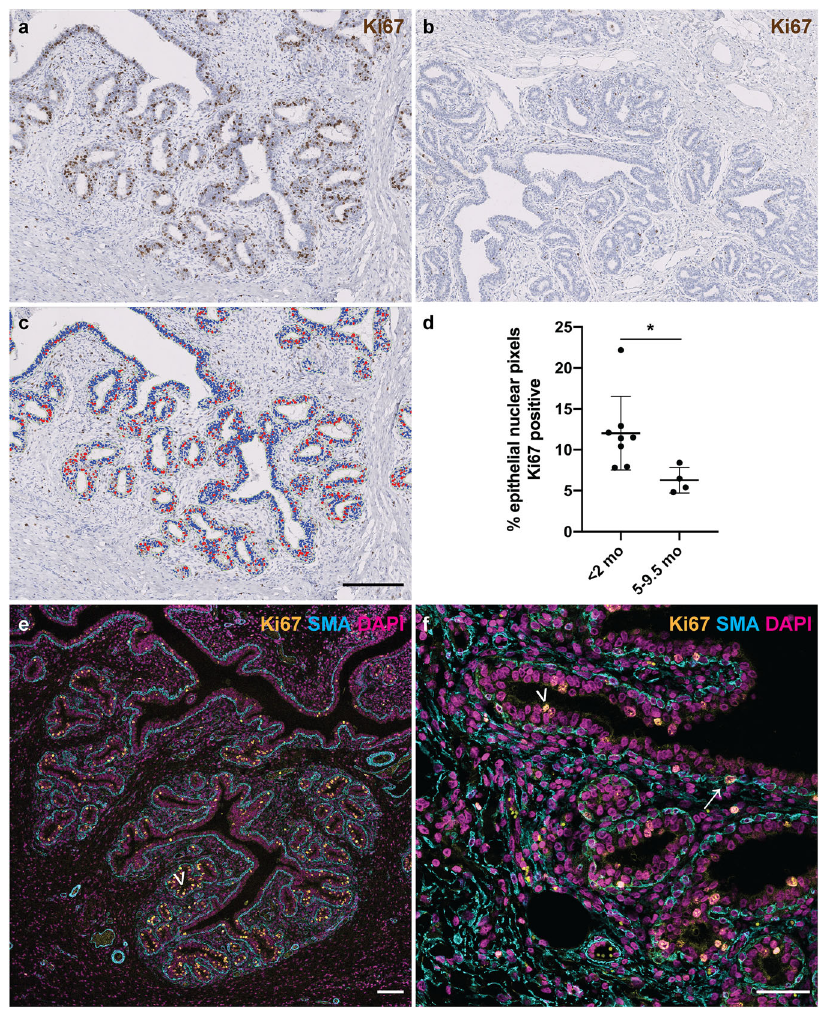
Fig. 2 Mammary epithelial proliferation is signi fi cantly higher in younger lambs than in those approaching puberty. a – c IHC for Ki67 in mammary gland from lambs < 2 mo ( a ) and 5 – 9.5 mo ( b ) and accompanying mask derived using an algorithm detecting intra-epithelial Ki67 positive events ( c ). d Scatter plot demonstrating that the distributions of epithelial nuclear Ki67 positivity differ signi fi cantly between younger and older lambs. Dots represent individual lambs. Bars represent mean ± standard deviation. * p < 0.05. e , f IF for Ki67 (gold), α -SMA (cyan) and DNA (DAPI; magenta) demonstrating that the majority of Ki67 positive nuclei are in the luminal epithelial layer (arrowheads), with rare Ki67 positive nuclei in myoepithelial cells (arrow). e 1 do lamb. f 9.5 mo lamb. do, days old; mo, months old. Images are representative of eight ( a ), four ( b ), twelve ( c ) and three ( e , f ) biological repeats. All IHC images have haematoxylin counterstain. Scale bar = 200 μ m ( a – c ); 100 μ m ( e ); 50 μ m ( f